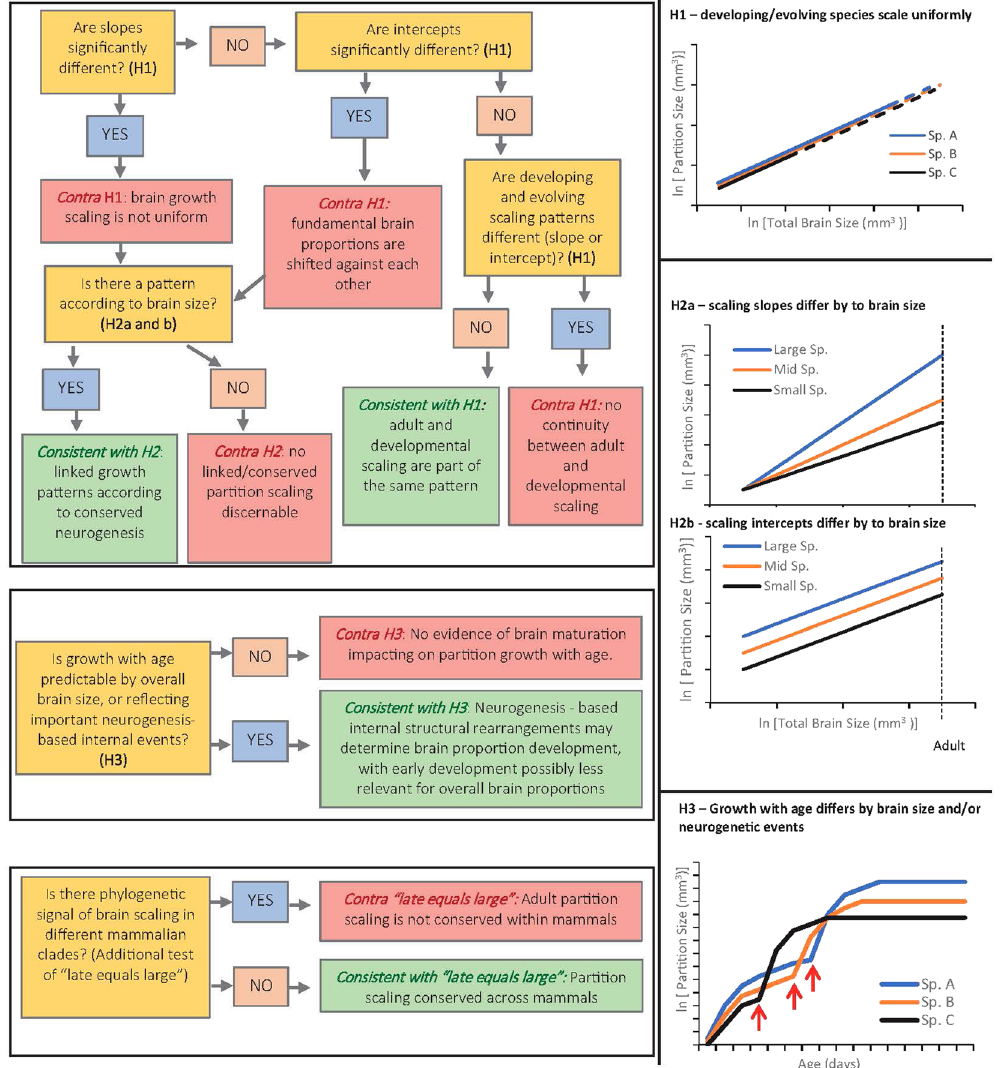
Figure 2. Flowchart outlining the hypotheses examined and interpretation of analyses conducted in this study (see introduction). H1, H2 and H3 refer to the three hypotheses for which accompanying graphs provide supporting visual representations: H1) Brain scaling slopes and intercepts are not significantly different between developing species, between evolving species (adult), or between developing and evolving brains (dotted lines signify continuation of brain scaling through adult brain sizes); H2a) and ( b ) example scenarios of a change in slope (H2a) or intercept (H2b) in the scaling of a partition according to brain size; and H3) all species growth patterns show growth irregularities attributable to neurogenesis and predictable by adult size (red arrows mark the occurrence of an important neurogenetic event as well as the onset of a growth